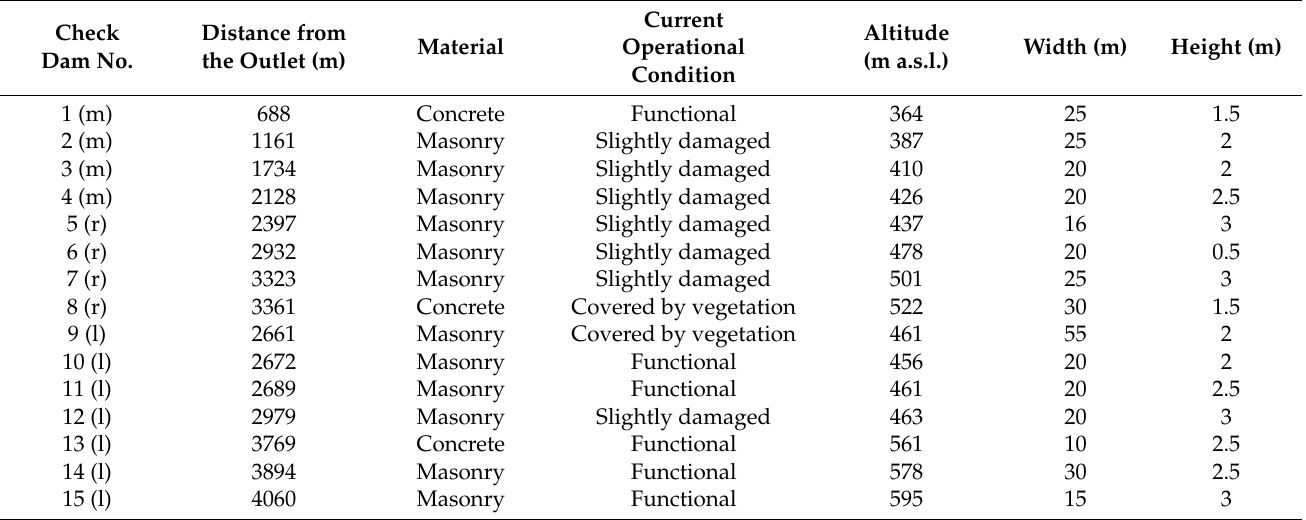
Table 2. Main dimensional characteristics of the 14 check dams in the Vacale headwater under investigation. (Calabria, Southern